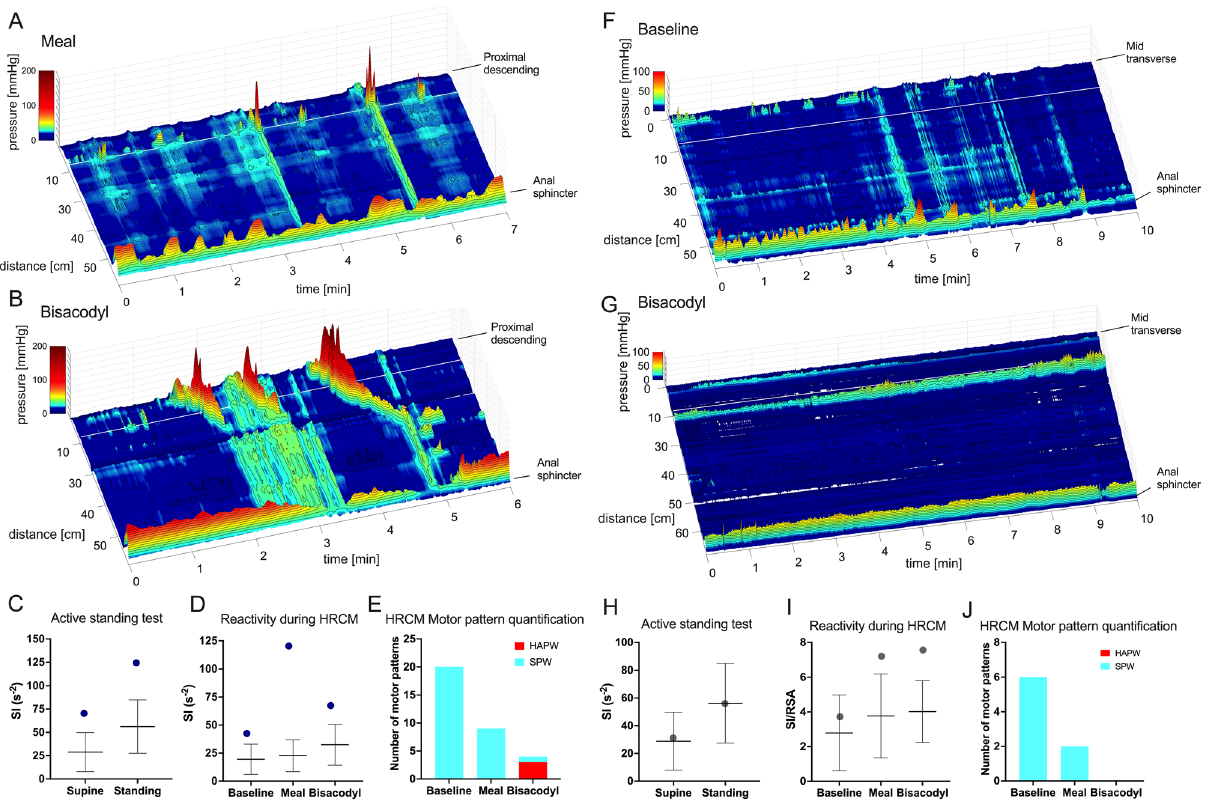
Figure 5. Decreased motility associated with high sympathetic tone and high sympathetic reactivity in patient #7 ( A – E ), and patient #12 ( F – J ). Sympathetic tone and reactivity are reflected by the sympathetic index SI or SI/ RSA. ( A ) Patient #7 had dominant simultaneous pressure waves in response to the meal which was associated with very high sympathetic reactivity. ( B ) Rectal bisacodyl evoked a normal sacral autonomic reflex: descending colon HAPWs with a normal coloanal reflex, ( C ) this patient showed high SI tone and reactivity during the active standing test prior to HRCM, and ( D ) a decrease in SI reactivity in response to bisacodyl compared to the meal. ( E ) An increase in HAPWs occurred in response to rectal bisacodyl. ( F ) Patient #12 had a complete absence of HAPWs but SPWs were evoked during baseline when the autonomic balance (SI/RSA) was normal. ( G ) No SPWs occurred in response to rectal bisacodyl. ( H ) This patient showed normal sympathetic tone and reactivity assessed by the active standing test. ( I ) and ( J ) The decrease in SPWs in response to the meal and rectal bisacodyl was associated with high SI/RSA. The gastrocolic and the sacral autonomic reflex did not occur. The white lines represent a gap of 10 cm where a balloon was attached to the